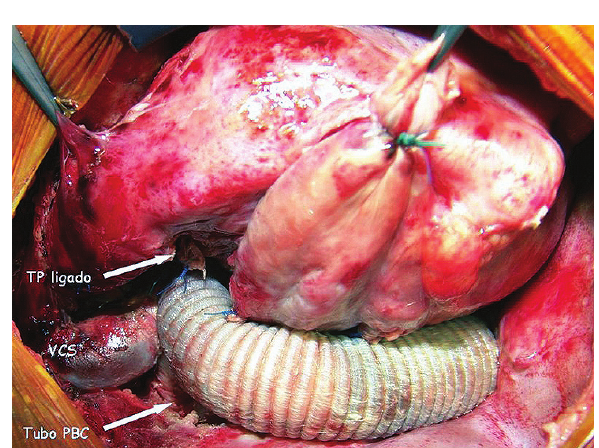
Fig. 2 – Tubo de pericárdio bovino corrugado (PBC) conectando a veia cava inferior à artéria pulmonar. A veia cava superior (VCS) também foi anastomosada à artéria pulmonar e o tronco pulmonar (TP)